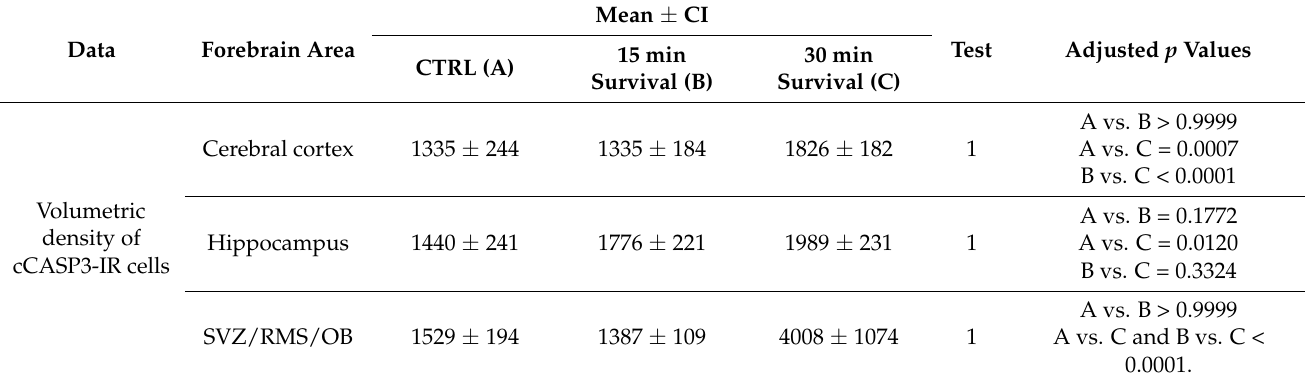
Table A3. Statistical analysis of volumetric densities and percentages of cCASP3 immunoreactive cells. Legend : 1 = Kruskal-Wallis and Dunn’s multiple comparisons test. See Figure 8 for graphs.